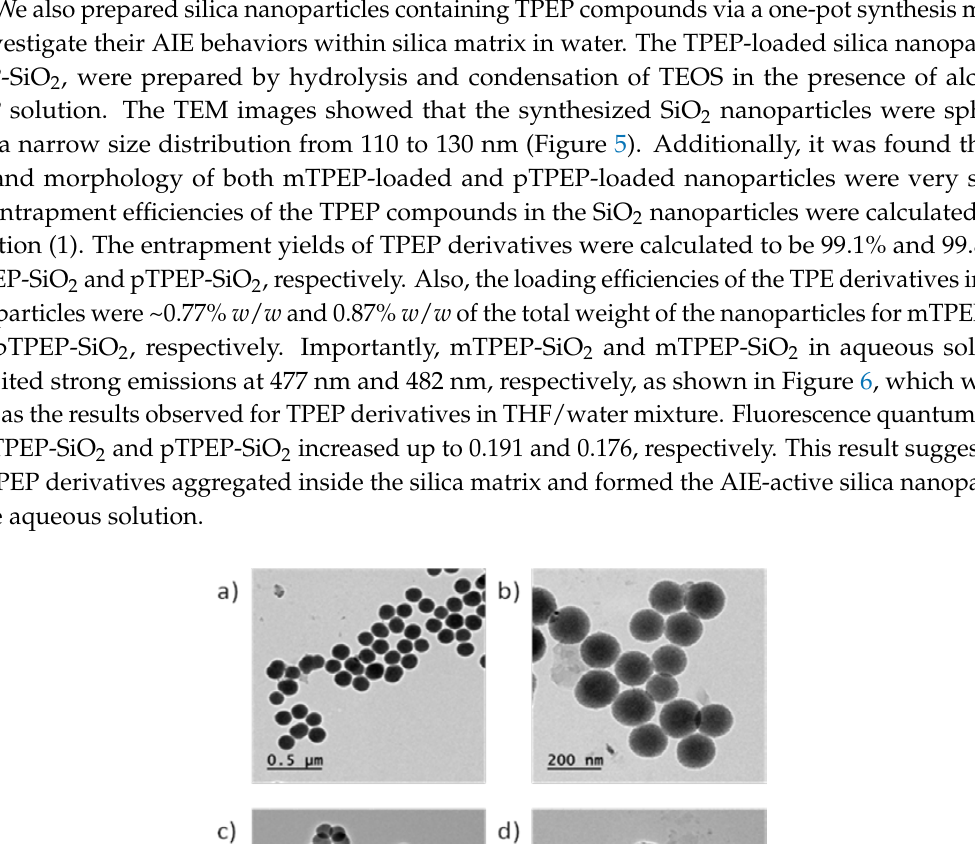
2 and ( c , d ) pTPEP-SiO 2